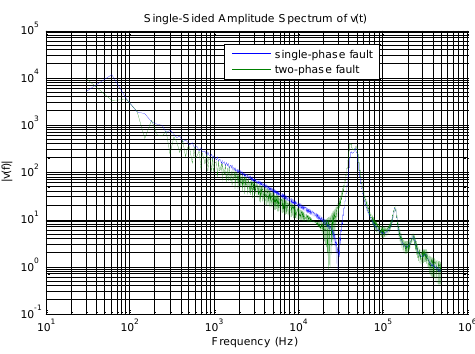
Fig. 18. FFT analysis for phase-c secondary voltage